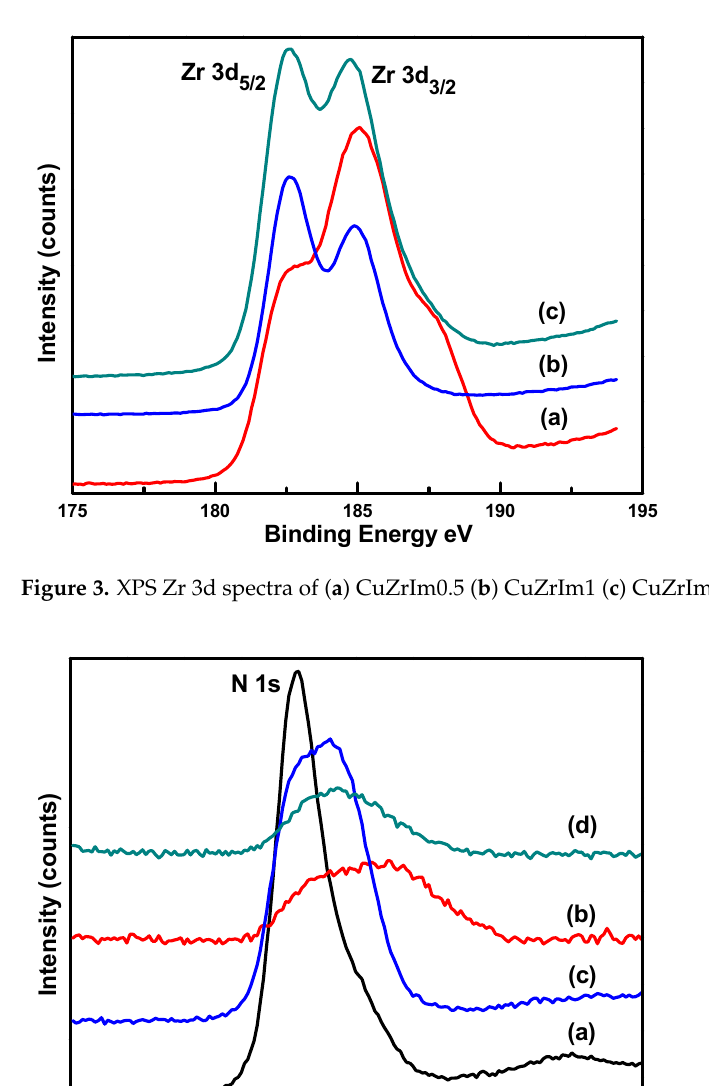
Figure 2. XPS Cu 2p spectra of ( a ) CuIm ( b ) CuZrIm0.5 ( c ) CuZrIm1 ( d ) CuZrIm1.5.